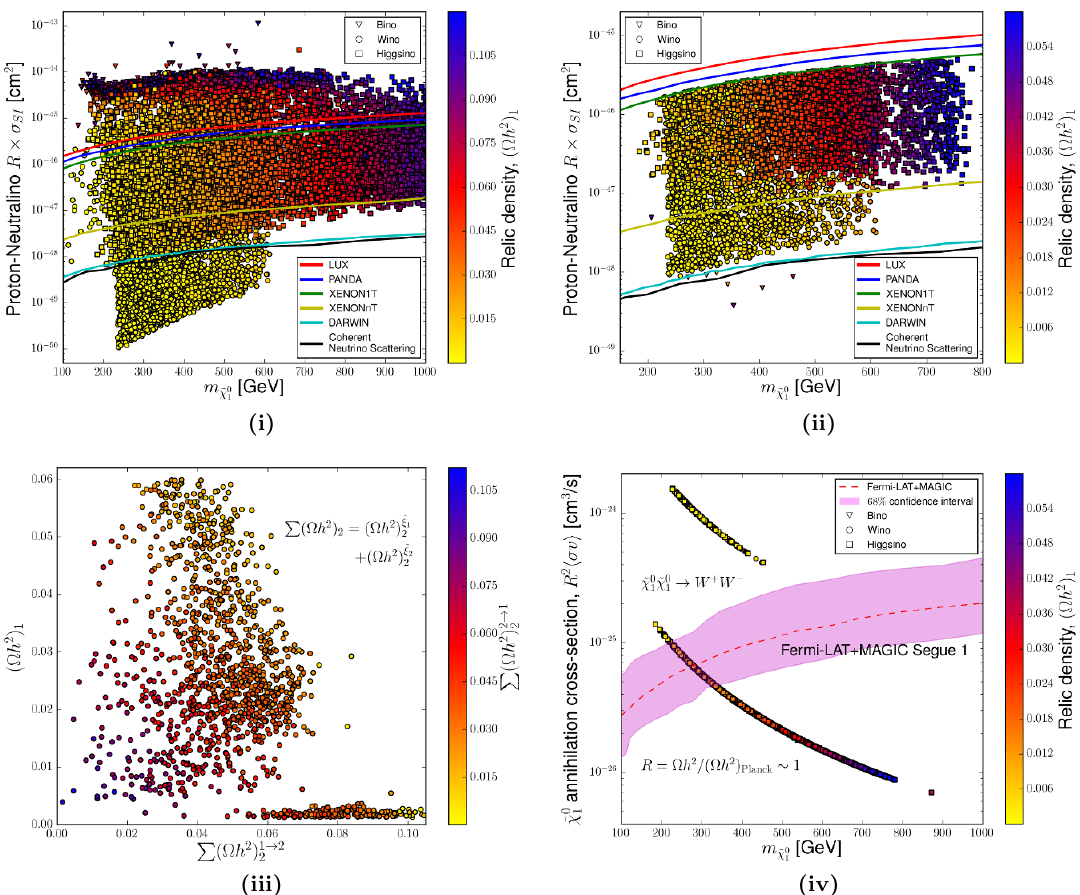
Figure 1. Panels (i), (ii): scatter plots of the proton-neutralino spin-independent cross-section, R (cid:2) (cid:27) SI , (in cm 2 ) versus the neutralino mass (in GeV), where R = ((cid:10) h 2 ) 1 = ((cid:10) h 2 ) PLANCK . The bino, wino and higgsino nature of the LSP is exhibited by three markers (see legend). Panel (i) shows all points satisfying the Higgs boson mass and ((cid:10) h 2 ) 1 < 0 : 12 while panel (ii) includes the additional constraint from the XENON1T limit on direct detection and the contribution to R from the hidden sector ( R = (cid:10) h 2 = ((cid:10) h 2 ) PLANCK (cid:24) 1). Panel (iii): plot shows the di(cid:11)erent relic density contributions, namely, the freeze-out (along y -axis), all A ! B + (cid:24) freeze-in processes ( x -axis) and the smaller freeze-in contribution from A + B ! (cid:24) processes where the relative contributions are indicated by color coding. Panel (iv) shows the neutralino annihilation cross-section versus the neutralino mass in the W + W (cid:0) channel with the combined limit from Fermi-LAT and MAGIC experiments where the 68% con(cid:12)dence interval is shown. The colors bar to the right of the panels (i), (ii) and (iv) gives the contribution ((cid:10) h 2 ) 1 to the freeze-out relic density. Points corresponding to hidden sector neutralinos with lifetimes longer than 10 seconds are removed from panels (iii) and (iv).